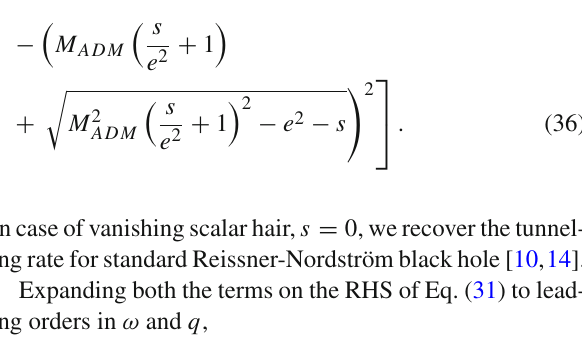
ing temperature T BH of the scalar-hairy RN black hole with respect to the electric charge e for different values of the scalar charge s with M ADM =